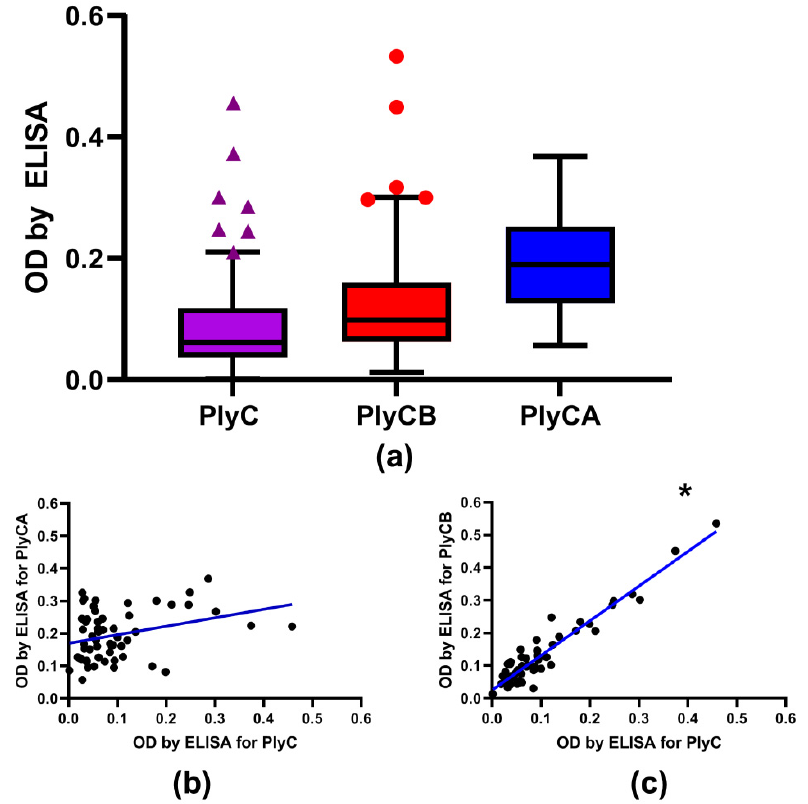
Figure 4. IgG reactivity against PlyC and its subunits, PlyCA and PlyCB, in human sera. Blood sera from healthy volunteers ( n = 56) were tested against recombinant PlyC, PlyCA, and PlyCB by ELISA. ( a ) Levels of antibodies as ELISA signals; the mean value was presented as the vertical line, 25th and 75th percentile were presented as the box, whiskers designate outliers cut-off, points (triangles or circles) represent outliers in each group, * indicates a p -value of <0.0001, and all five outliers that demonstrated the highest levels of anti-PlyCB IgG (circles) and also the highest levels of anti-PlyC IgG’s (triangles). ( b ) Correlation (blue line) between levels of antibodies specific to PlyC and antibodies specific to PlyCA (insignificant). ( c ) Correlation (blue line) between levels of antibodies specific to PlyC and antibodies specific to PlyCB. The correlation between levels of antibodies specific for PlyC and PlyCB was statistically significant ( p < 0.0001).